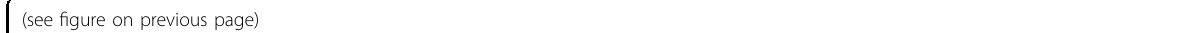
Fig. 1 ECCA selectively blocks the growth of melanoma cells compared to human primary melanocytes. A Five melanoma cell lines were treated with different concentrations of ECCA as indicated, with DMSO used as a control. At 48 h, cells were collected and analyzed by the CCK8 assay for cell viability. B UACC62 cells were treated with different concentrations of ECCA as indicated, with DMSO as a control. Cells were collected at the different time points indicated and were analyzed by the CCK8 assay for cell viability. C UACC62 cells and human primary melanocytes were treated with or without various concentrations of ECCA as shown. At 48 h, cells were collected and analyzed by the CCK8 assay for cell viability. D Representative images of cell colony formation assays with or without different concentrations of ECCA as indicated at 7 days using crystal violet staining. Scale bar represents 5 mm. E Quanti fi cation of cell colony numbers in D . F Representative images of immuno fl uorescence staining of EDU (green) at 24 h after ECCA treatment at different concentrations as indicated. DAPI (blue) stain indicates nuclei. White arrows indicate EDU-positive cells. Scale bars represent 100 μ m. G Quanti fi cation of EDU-positive cell percentage (%) of a total of 500 DAPI-positive cells in F . All experiments were carried out three times, and error bars represent means + SD; P values are indicated with “ * ” , * indicates P < 0.05, ** indicates P < 0.01, *** indicates P < 0.005 when comparing ECCA-treated cells with the control group in A , B , E , and G by Student ’ s t test and comparing two groups as indicated in C by ANOVA